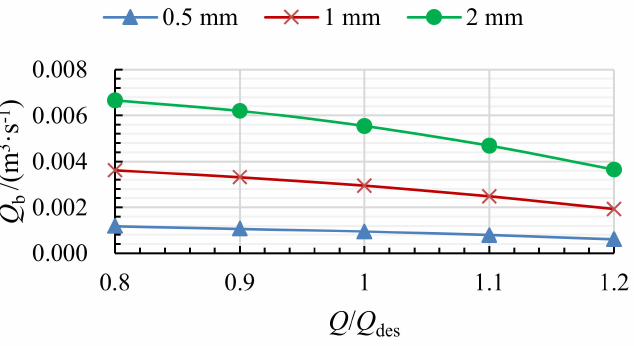
Figure 14. Leakage flow rate of three backflow clearances under different operation flow